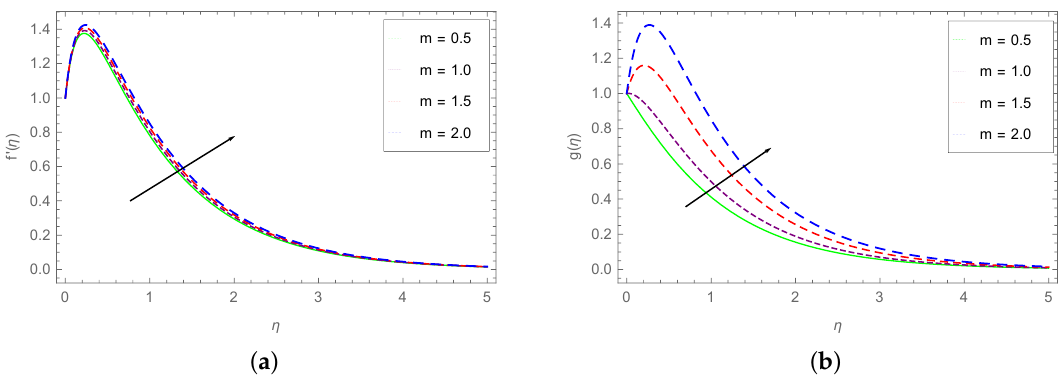
Figure 3. ( a ) f (cid:48) ( η ) dependence on m and ( b ) g ( η ) variation with m . (cid:48) ( η ) and g ( η ) with varying Weissenberg number Figure 4a,b show the variations of f ( We ). The values of We used in the present computation are 0.30, 0.50, 0.70, 0.90. From (cid:48) ( η ) and g ( η ) display almost similar decreasing these two figures, it is observed that both f trend with the increasing We . Thus, it is clear that the enhancing viscous nature of the Carreau fluid associated with the rising We constricts the fluid flow and hence reduces the fluid velocity.